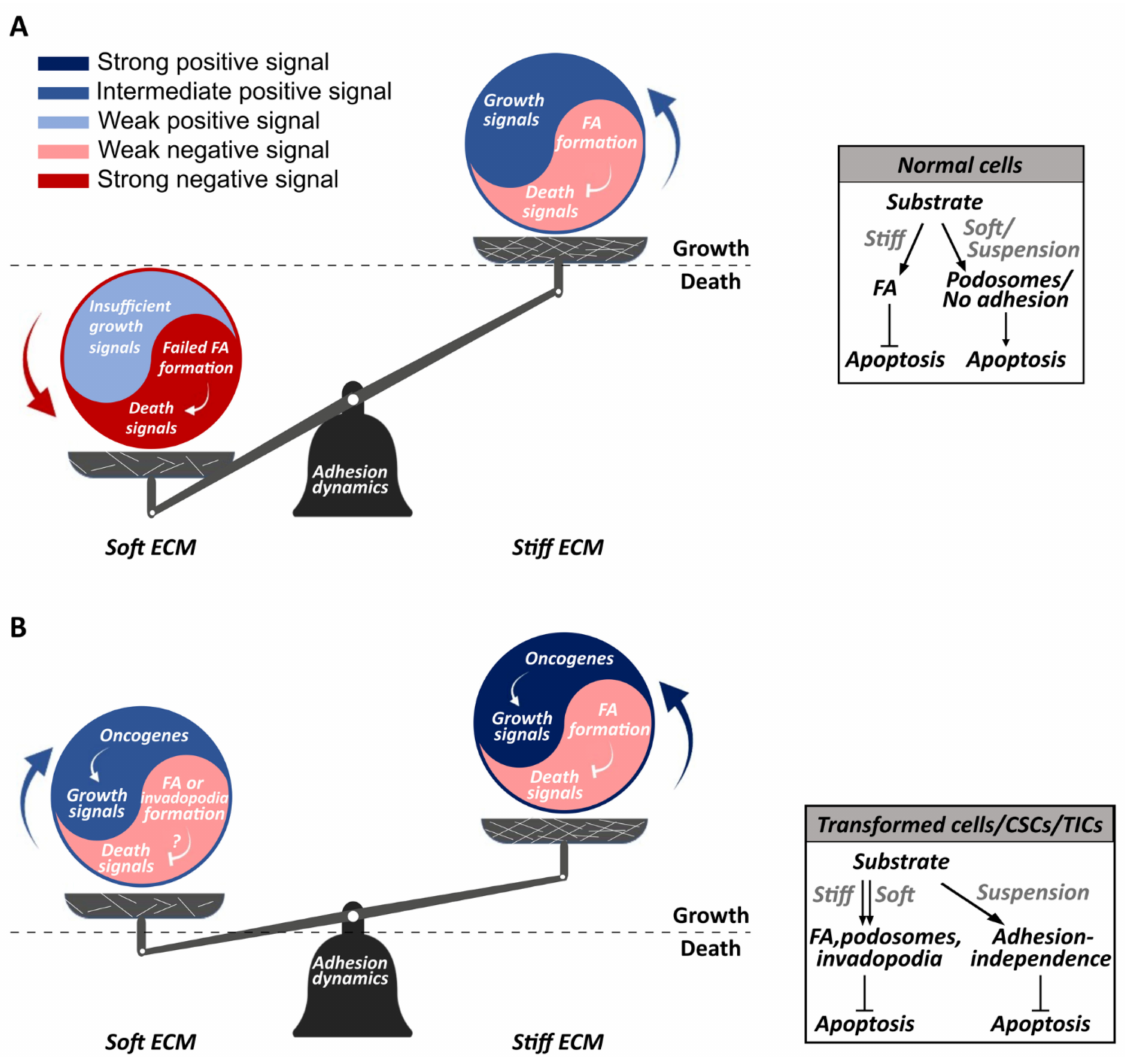
Figure 1. The ‘yin and yang’ of cancer cell growth and mechanosensing. An illustration of the relationship between ECM rigidity and cell growth, where ‘yin’ (red) represents the cellular response to negative mechanical stimuli (e.g., a soft ECM), and ‘yang’ (blue) represents positive growth signals (see figure key). ( A ) In normal cells, the negative mechanical signals from a soft ECM are stronger than the positive signals, causing the cells to undergo anoikis. ( B ) In anchorage-independent transformed cells, the balance shifts and cells grow regardless of ECM